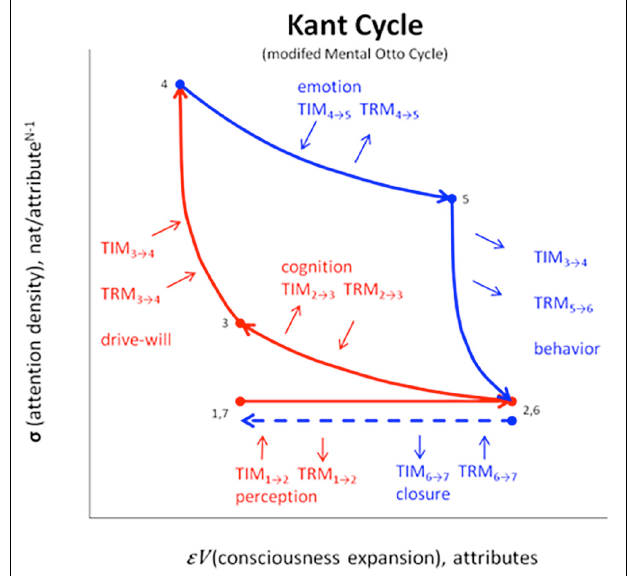
FIGURE 4 | The Kant Cycle is a mental analog of the Otto Cycle. During perception (stroke 1 → 2), task-relevant meaning TRM 1 → 2 flows from the mind into the sensory effectors (e.g., eye muscles), expanding consciousness at a low level of attention as task-irrelevant meaning TIM 1 → 2 flows in from the sensors. During cognition (1 → 2), task-relevant and task-irrelevant meaning (TRM 1 → 2 , TIM 1 → 2 ) enter the mind from memory dropping consciousness and raising attention. On leg 1 → 2, drives such as hunger, thirst, ... and the will trigger a stream of task-relevant and task-irrelevant meanings (TRM 2 → 4 , TIM 2 → 4 ) released from associations in memory into the mind. Attention and arousal rise sharply, although consciousness remains relatively fixed about the concepts recognized during cognition (3 → 4). During emotion (4 → 5), task-relevant and task-irrelevant meanings stream out of the mind into memory storage to form new associative bonds. Attention and arousal drop gradually as consciousness expands. During behavior (5 → 6), task-relevant and task-irrelevant meanings are transferred into the effectors (muscles and glands) as attention and arousal drop by modest expansion of consciousness. On the final stroke (closure 6 → 7), task-relevant information TRM 6 → 7 enters from the motor sensors as consciousness compresses and task-irrelevant information passes to the sensory effectors to complete the